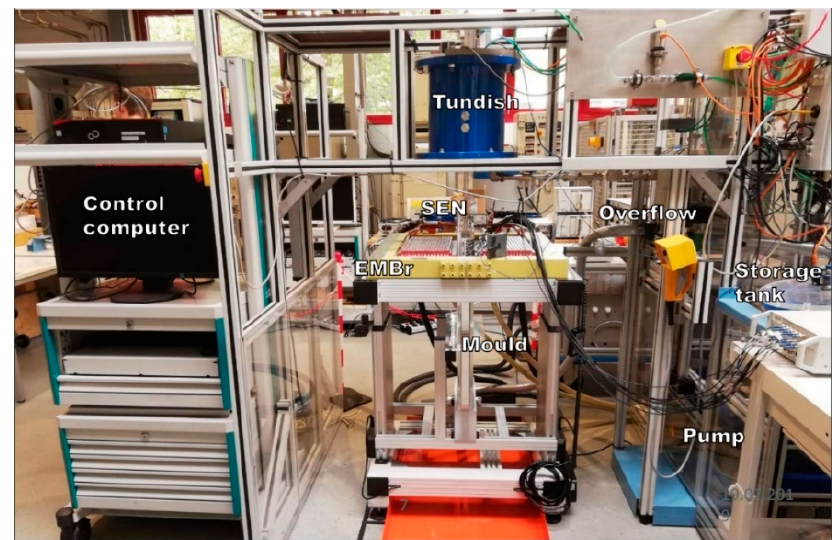
Figure 3. Mini-LIMMCAST Facility in HZDR.